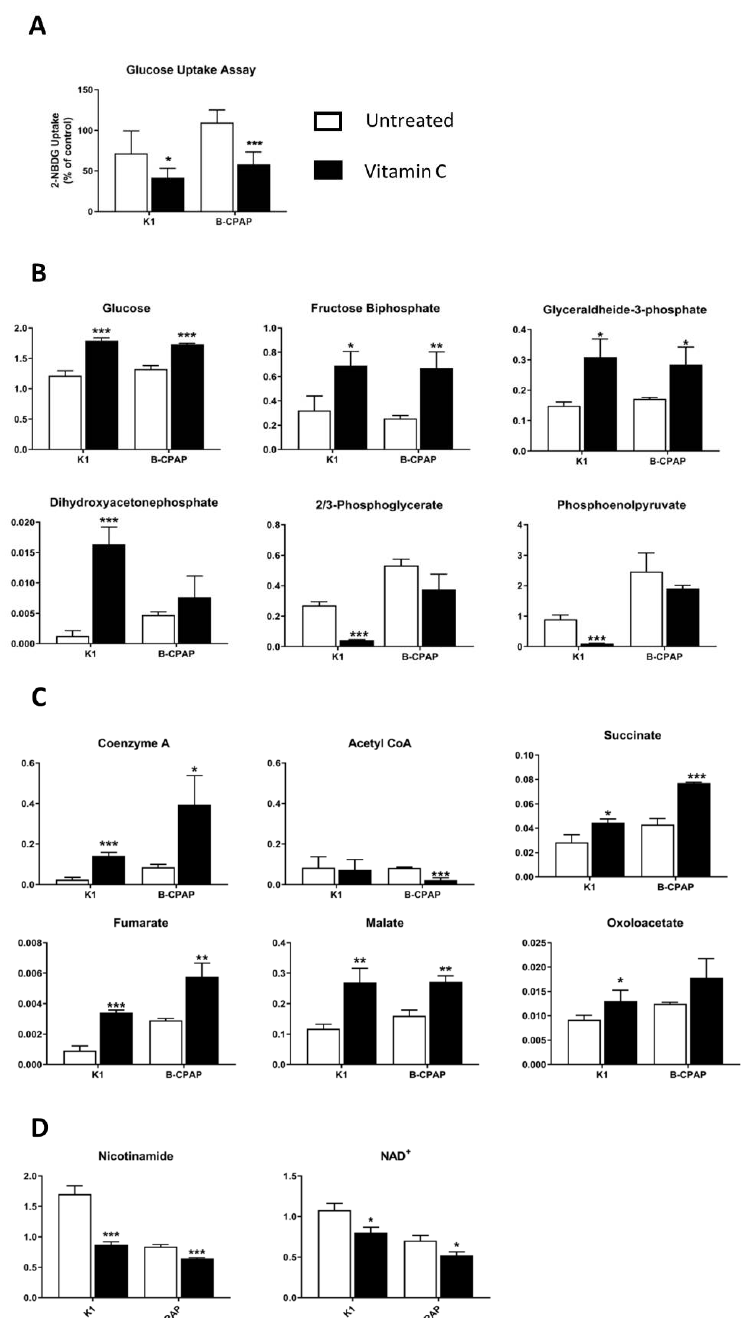
Figure 6. Metabolic alterations induced by vitamin C. ( A ) Quantification of the relative glucose uptake was done through the fluorescent glucose analog 2-NBDG in cancer cells treated with vitamin C. Data are expressed as media ± SD. ( B ) Intracellular levels of glycolytic pathway; ( C ) TCA cycle; ( D ) NAD + salvage pathway, and ATP level. Metabolites were measured after 24 h of incubation with vitamin C. Bar graphs indicate the peak areas of the metabolites, normalized for total area, and expressed in the graphs as ranks. All experiments were performed three times independently, each time in triplicate, to confirm the results. Statistical analyses were performed by Student t -test. Results were considered significant when: * p < 0.05; ** p < 0.01; *** p < 0.001.